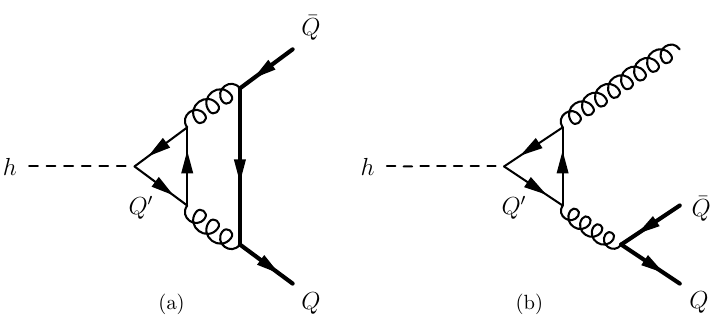
Figure 1 . The (cid:13)avor-singlet contributions to h ! Q (cid:22) Q and h ! Q (cid:22) Qg , where Q; Q 0 = t; b and h